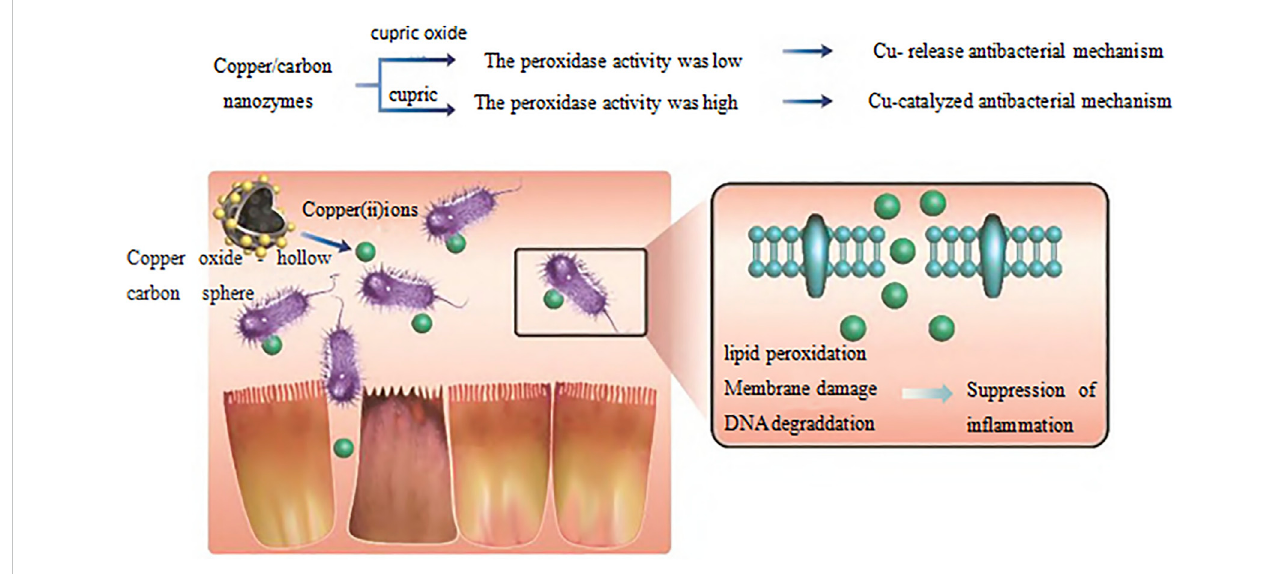
FIGURE 4 Cu/carbon hybrid nanozymes modi fi ed with different valence